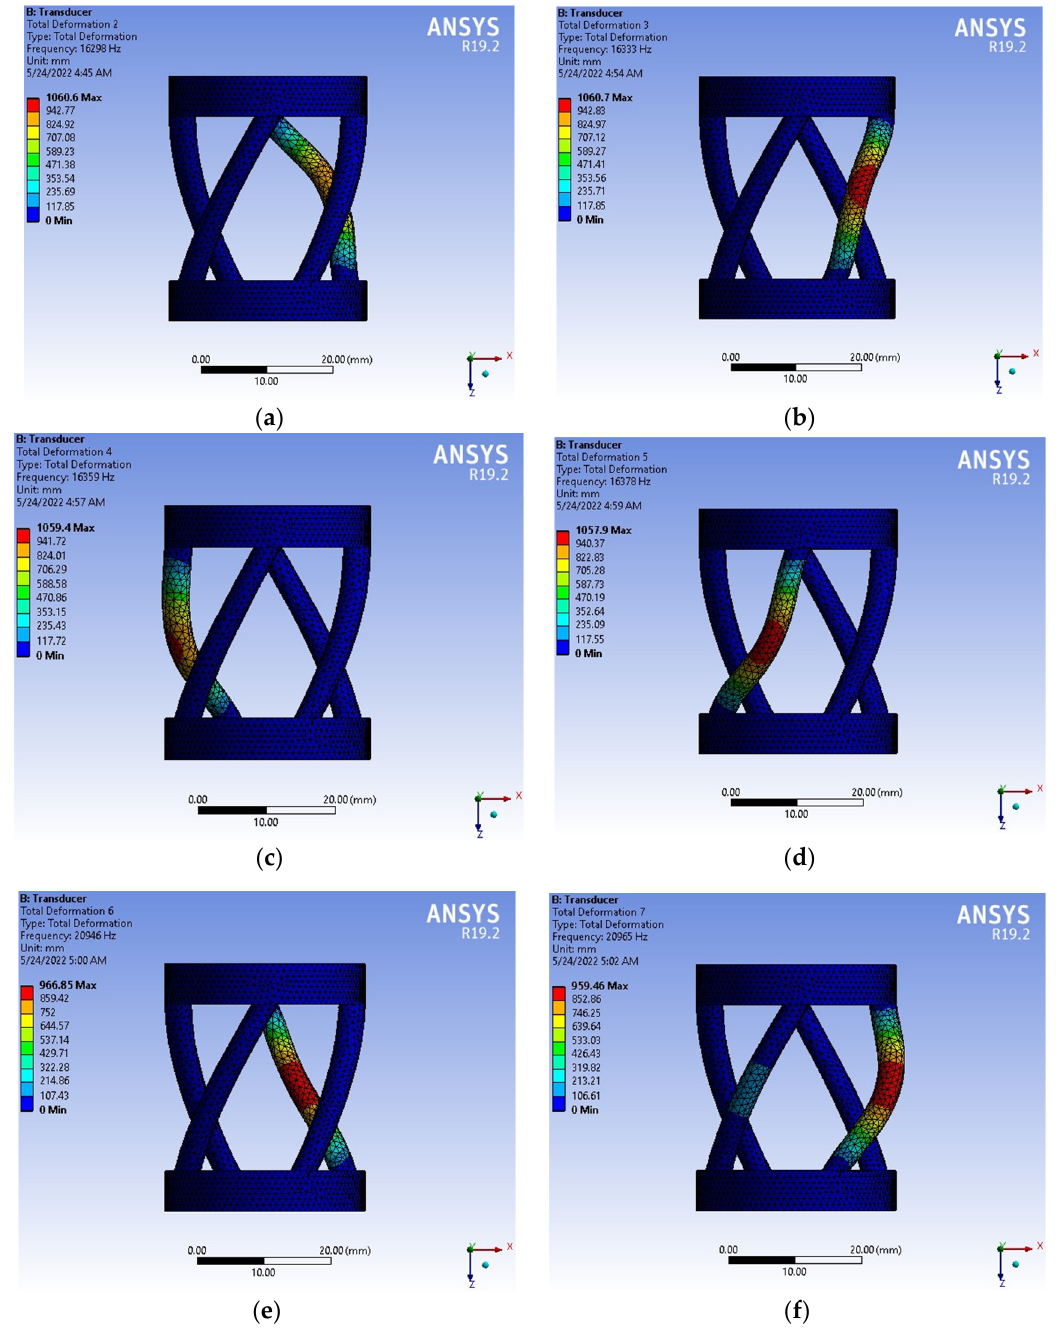
Figure 5. Values of vibration frequency for six modes of model. ( a ) Mode one. ( b ) Mode two. ( c ) Mode three. ( d ) Mode four. ( e ) Mode five. ( f ) Mode six.